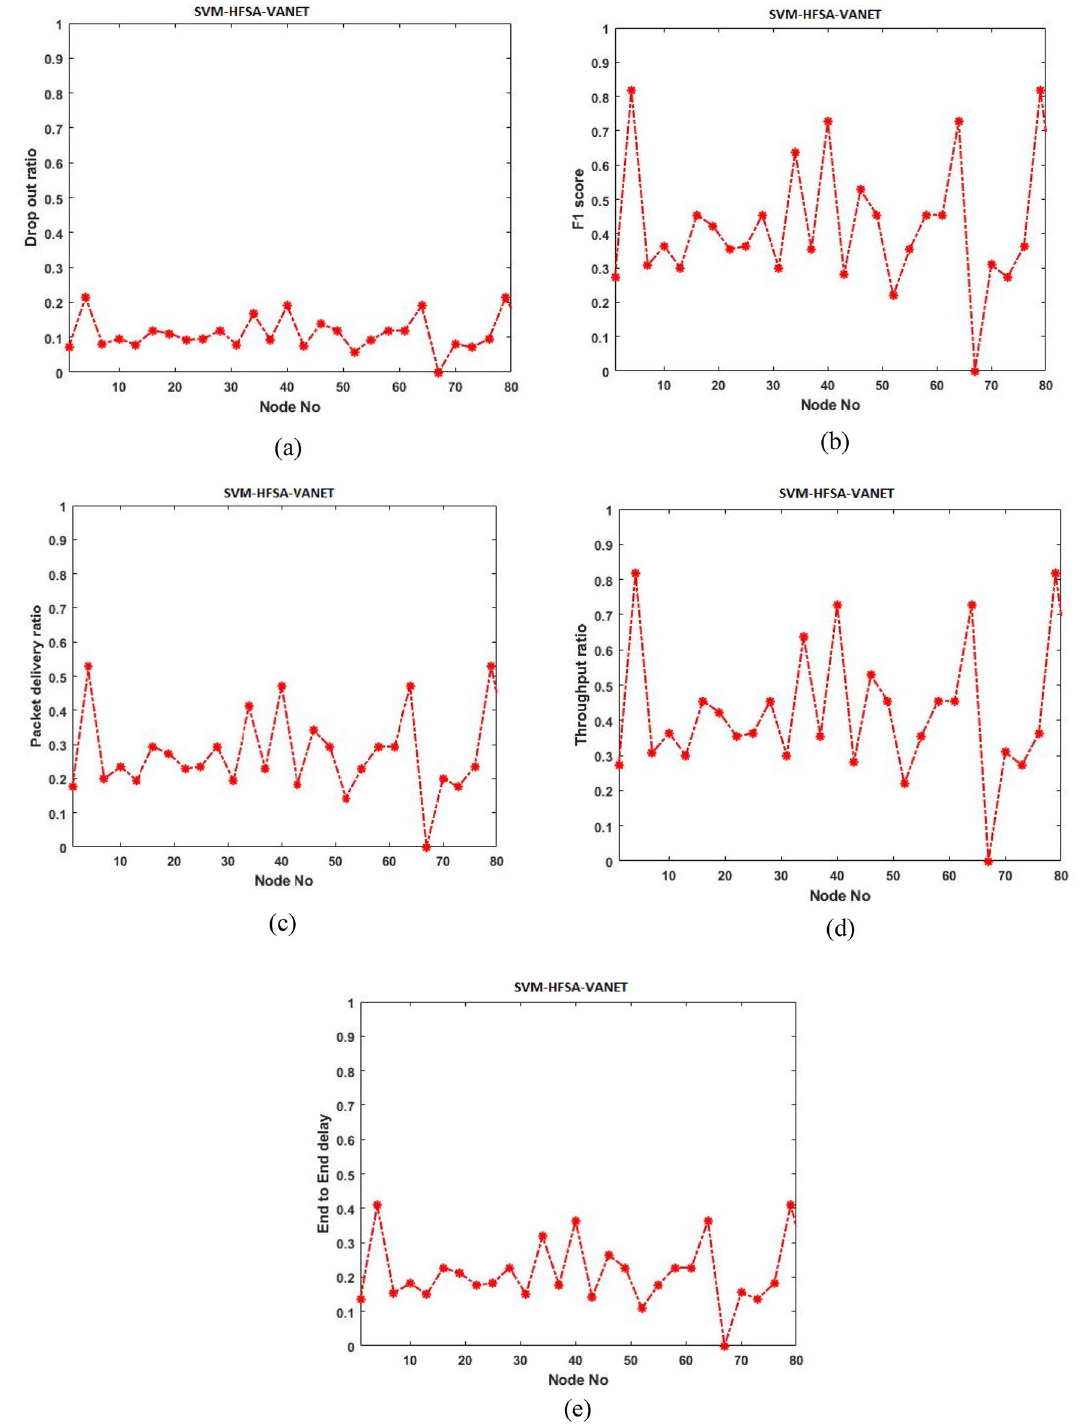
Figure 16. ( a ) Dropout ratio, ( b ) F1 score, ( c ) packet delivery ratio, ( d ) Through put ratio, ( e ) End to end